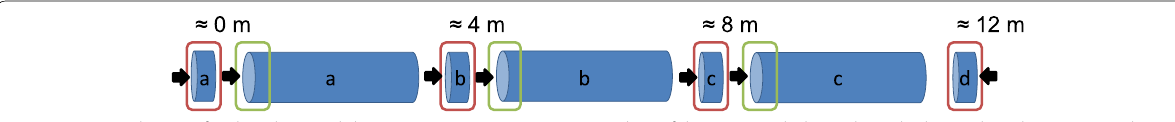
Fig. 3 Cutting diagram for short logs and discs. Cross‑section images were taken of the areas circled in red (on the logyard) and in green (at the sawmill line). The black arrows indicate the side that was photographed for each cross‑section